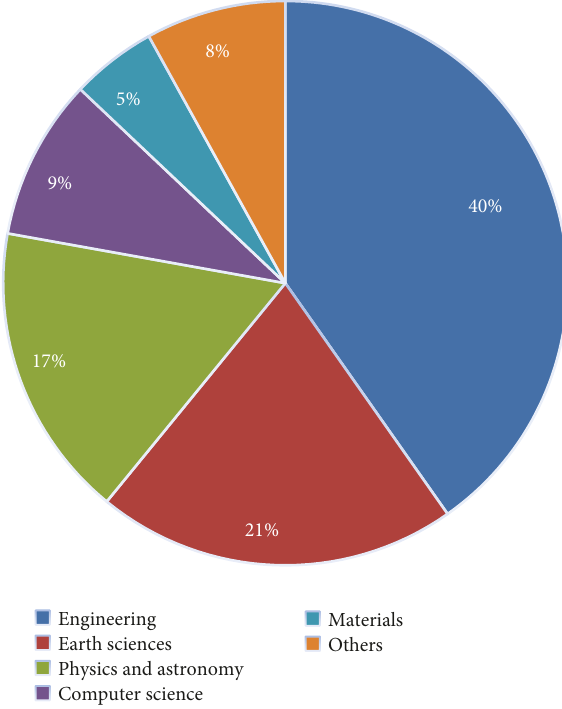
Figure 13: Distribution of CubeSat applications by knowledge